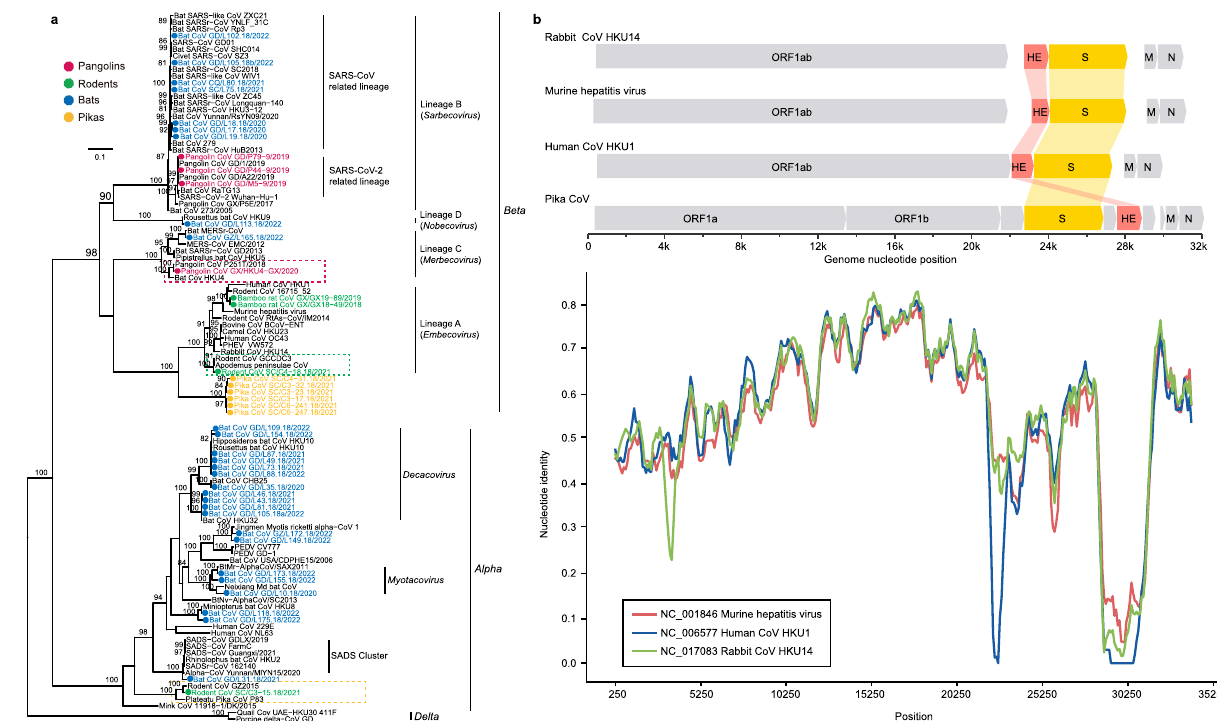
Fig. 2 |Phylogenetic diversityofthecoronavirusesidenti fi ed here.a Phylogeny of the Coronaviridae based on amino acid sequences of the RdRp gene. Viruses identi fi ed in this study are color-coded according to the animal from which they were sampled. The scale bar depicts the number of amino acid substitutions per